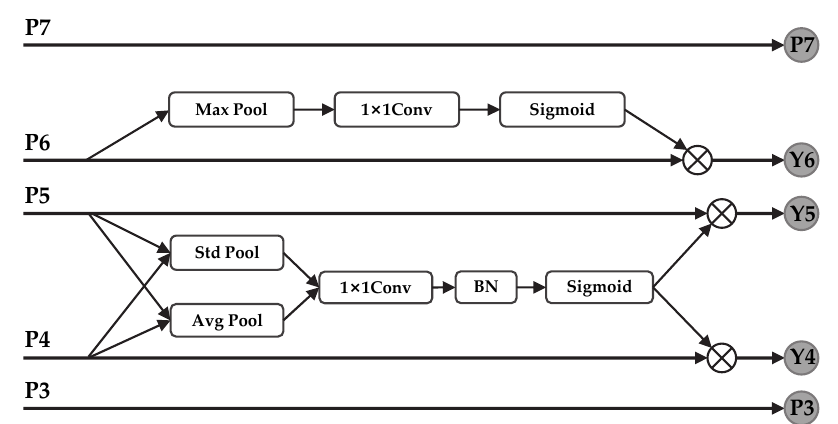
Figure 8. The structure of the Enhanced Feature Extraction Module. First, the middle feature layers, P4, P5 and P6, of the backbone feature network (corresponding to the lower, intermediate, and higher feature maps, respectively) are used as inputs, and the global information of the features is obtained by using Avgpool and Stdpool for the P4 and P5 layers, and Maxpool for P6 layer. Then, the interdependencies between channels are obtained through 1 × 1 convolution layers. After that, it is normalized by BN (the P6 layer does not it), and Sigmoid is taken to get the channel weights (0–1). Finally, the weights are multiplied by P4, P5 and P6 layers, respectively, as new feature layers and input to the BiFPN, while the feature fusion from top-down and bottom-up is iteratively performed. The top feature map has rich semantic information, Maxpool can well retain detail characteristics, such as texture, while the bottom feature map has high resolution, the background information can be well preserved with Avgpool and